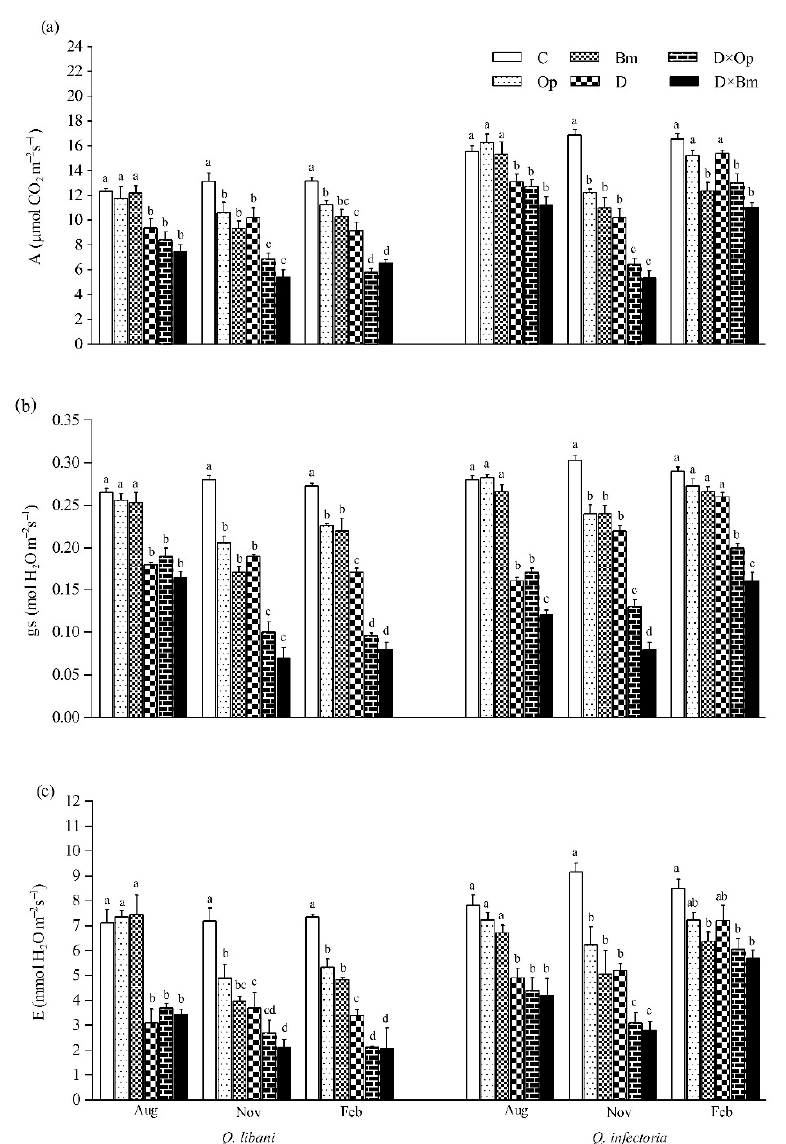
Figure 4. ( a ) Net photosynthesis rate (A); ( b ) stomatal conductance (g s ); and ( c ) transpiration (E) of Quercus libani and Q. infectoria seedlings affected by charcoal disease, drought and their combination assessed at intervals of three month starting three months after treatment initiation. Op: Obolarina persica , Bm: Biscogniauxia mediterranea , D: Drought, D × Op: Drought × O. persica and D × Bm: Drought × B. mediterranea . Bars represent means + standard error, n = 6. Different lower-case letters indicate statistically significant differences between the treatments at α = 0.05 based on Tukey’s multiple comparison